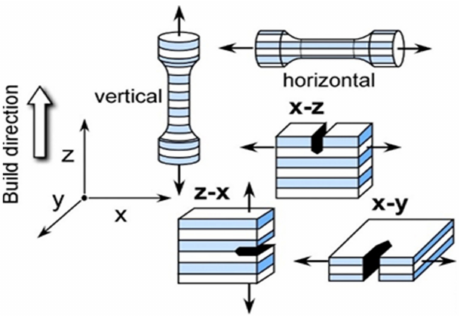
Figure 2. Notation used to relate the loading and crack plane orientation to the build direction in